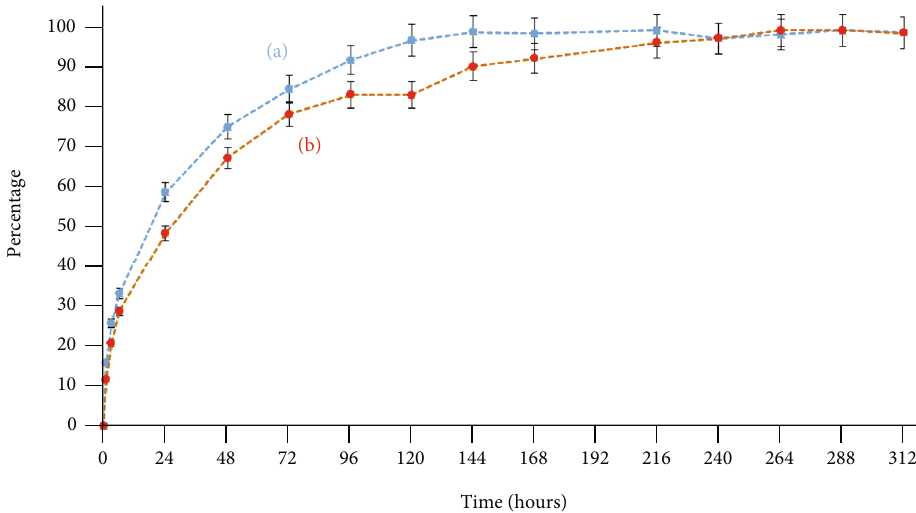
Figure 5: Release pro fi les (kinetic curves) of OZ-MP: (a) OZ-MP